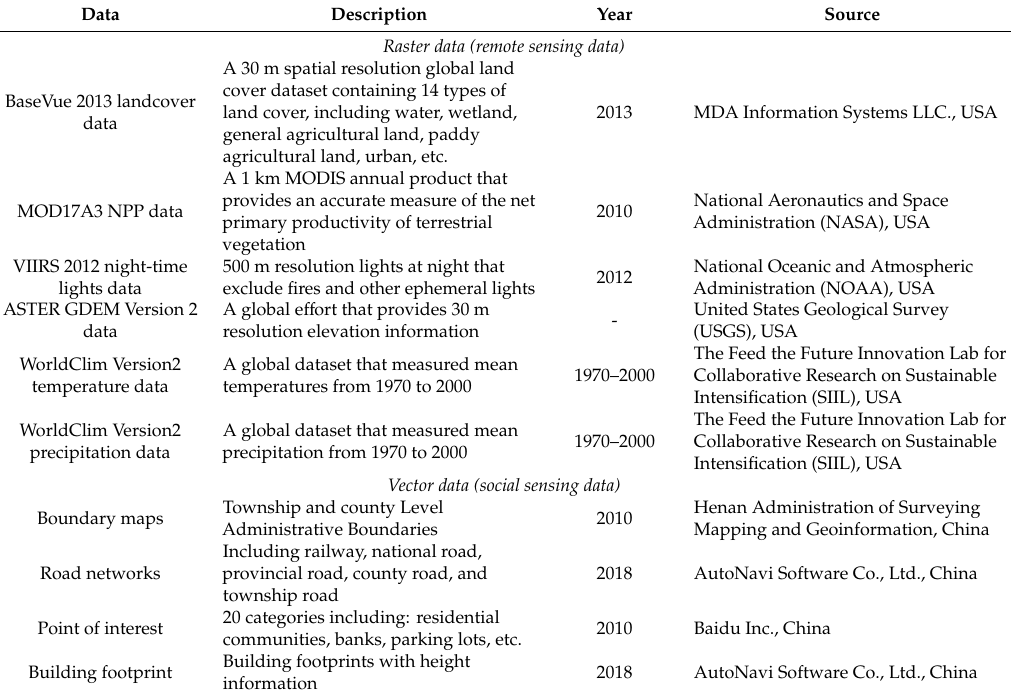
Table 1. List of ancillary data used in this